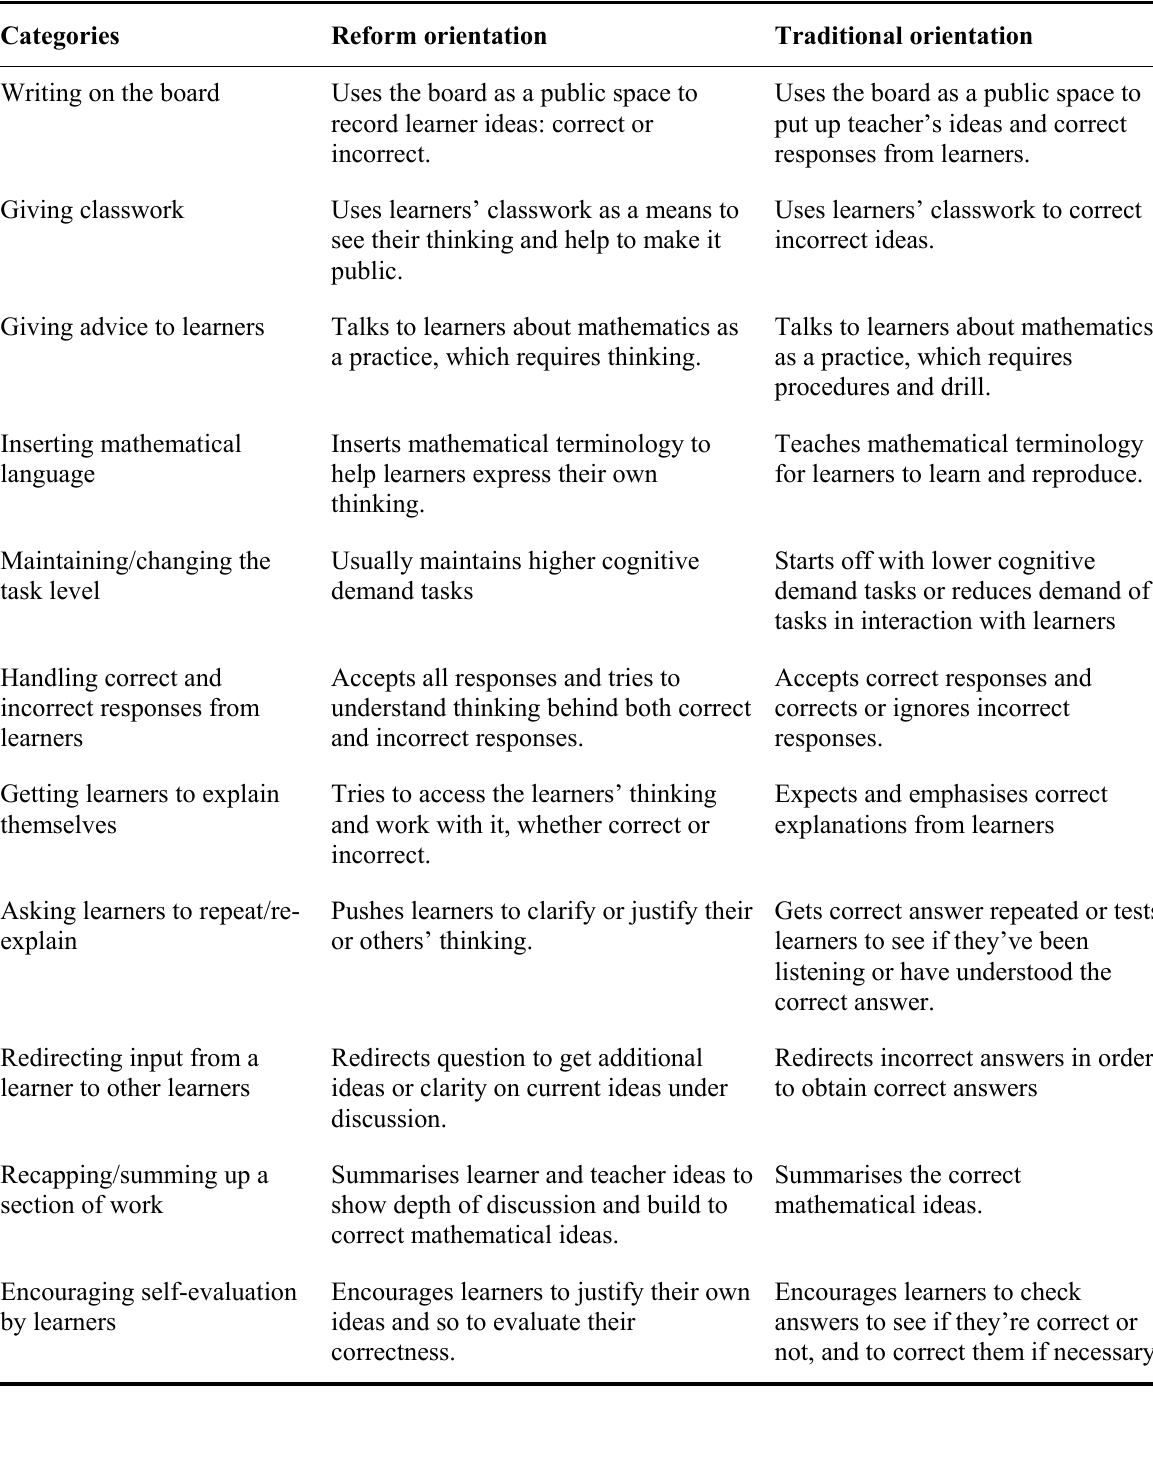
Table 1: Practices analytic